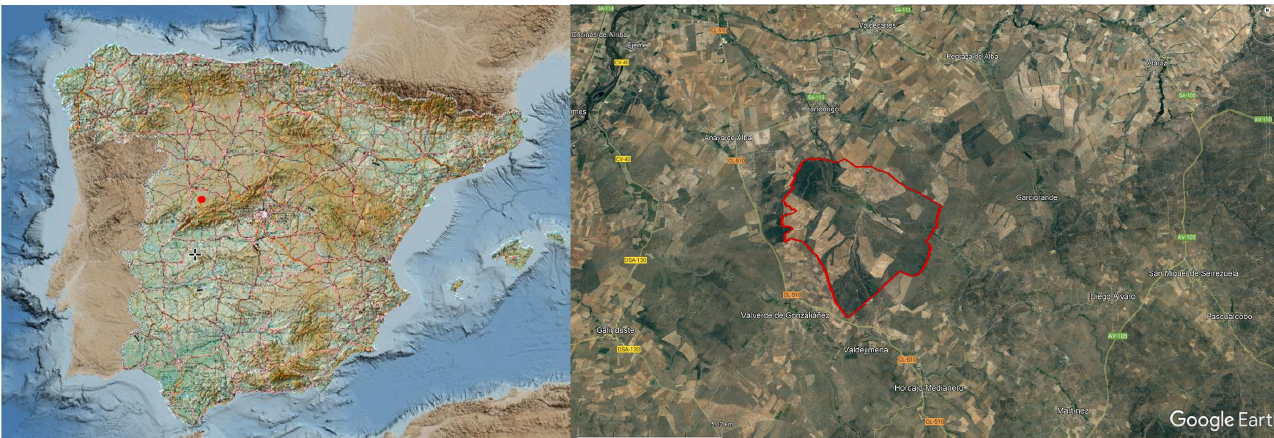
Figure 1. Situation map of Study area ( left ). The satellite image ( right ) shows the great importance of the conservation of the arboreal roots (dark green areas) scattered throughout a region in which bare soils are abundant (light brown color).